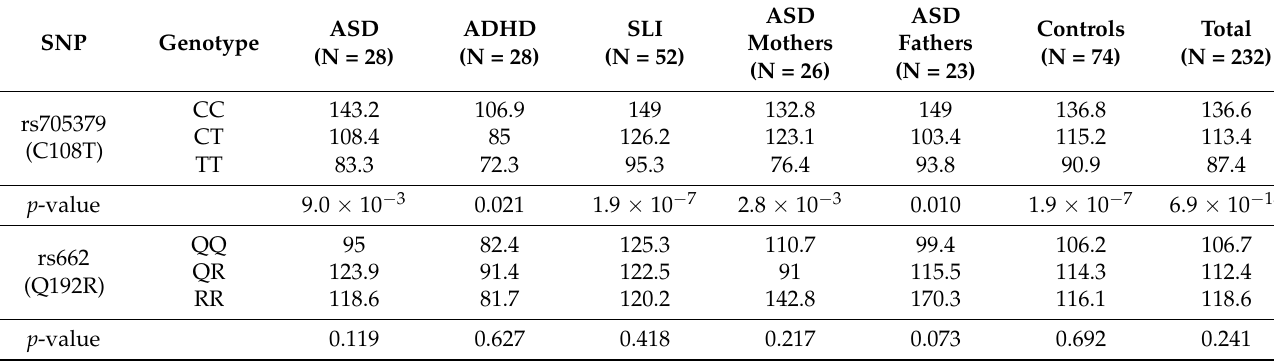
Table 3. Arylesterase activity levels in each sample for SNPs rs705379 (C-108T) and rs662